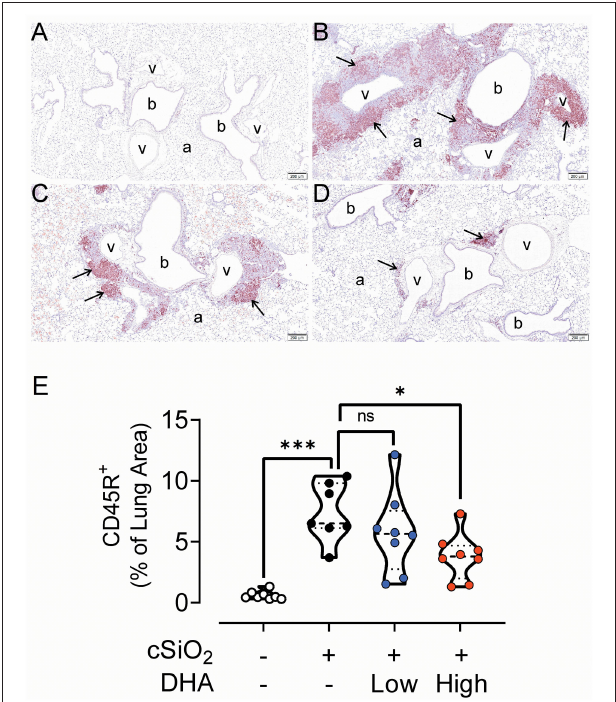
FIGURE 8 | DHA-containing diets reduce CD21/35 + follicular dendritic cell (FDC) infiltration in the lungs of cSiO 2 -treated mice. Light photomicrographs of lung tissue sections immunohistochemically stained for CD21/CD35 + FDC (arrows) from mice fed control diet and intranasally instilled with saline vehicle (Veh/CON, A ), fed control diet and intranasally instilled with cSiO 2 (cSiO 2 /CON, B ), fed 0.4% DHA diet starting one week after the end of the intranasal cSiO 2 instillations (cSiO 2 /low DHA, C ), or fed the 1.0% DHA diet starting one week after the end of the intranasal cSiO 2 instillations (cSiO 2 /high DHA, D ). Marked perivascular and peribronchiolar accumulations of follicular dendritic cells in lung of cSiO 2 /CON mouse. Moderate, minimal and no accumulations of follicular dendritic cells around blood vessels (v) and bronchioles (b) in cSiO 2 /low DHA (C) , cSiO 2 /high DHA (D) , and Veh/CON (A) mice, respectively. a, alveolar parenchyma. (E) depicts percentage of CD21/35 + stained tissue. Statistical comparisons were performed between groups, as described in the Methods section. * p ≤ 0.05, ns = not significant.